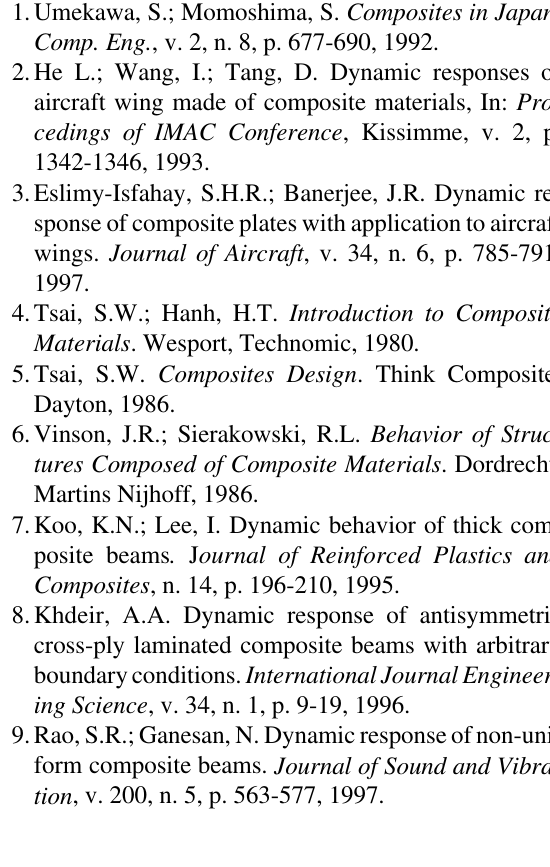
Table 4. Natural damped frequencies from FEA and experimental test. Mode